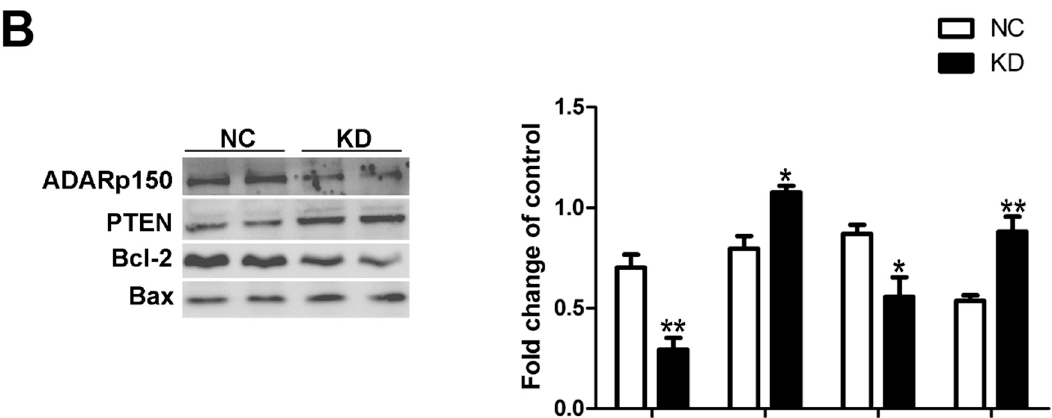
Figure 8. The effect of ADAR1p150 on cell viability in NRC infected with CVB3. ( A ) The value of CCK-8was significantly reduced after we knocked down ADAR1p150 in the NRC infected with CVB3 at 24 and 48h (* p < 0.05). ( B ) The expression of PTEN and BAX were evaluated (* p < 0.05, ** p < 0.01) and Bcl-2 was reduced compared with the control group (* p < 0.05).